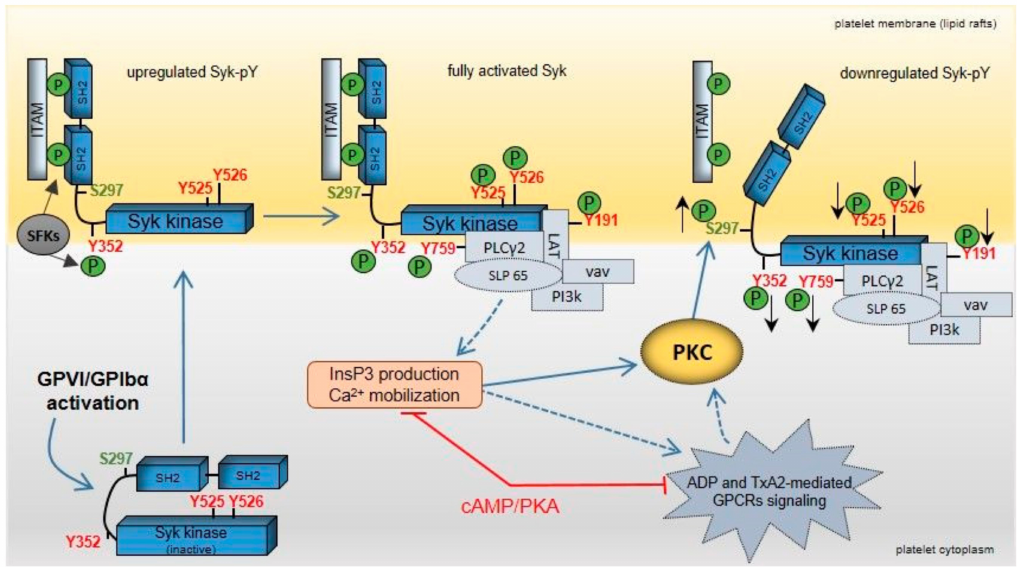
Figure 10. Model showing feedback regulation of Syk upon GPVI and GPIb α activation in human platelets. Clustering of GPVI and GPIb α upon agonist binding activates platelets initiated by src family kinases (SFKs) and the spleen tyrosine kinase (Syk). SFK activation leads to dual phosphorylation of the “immunoreceptor tyrosine-based activation motifs” (ITAMs), which represents a docking site for the two src homology 2 (SH2) domains of Syk. The interaction between Syk-(SH2) 2 domains and dually tyrosine-phosphorylated ITAMs recruits and translocates Syk to lipid rafts of the platelet cell membrane. Syk tyrosine phosphorylation of Y525 / 526 (kinase domain) and Y352 (interdomain-B) by autophosphorylation and SFKs leads to a fully activated kinase. Consequently, specific Syk substrates and regulatory proteins, such as LAT, PLC γ 2, SLP65, vav, and phosphoinositide-3 kinase (PI3k)